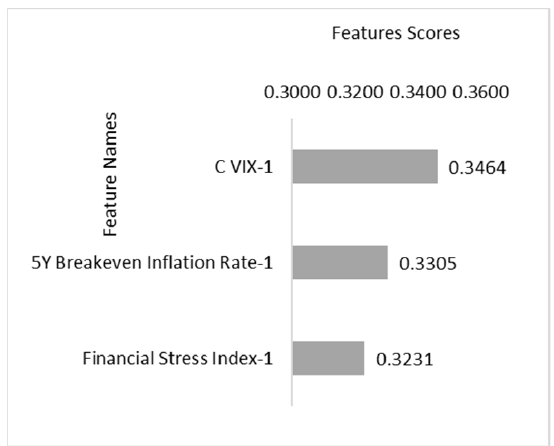
Figure 6. Top three weekly ranked features from XG Boost. The numbers on the right, truncated to four decimal places, are the features’ scores.